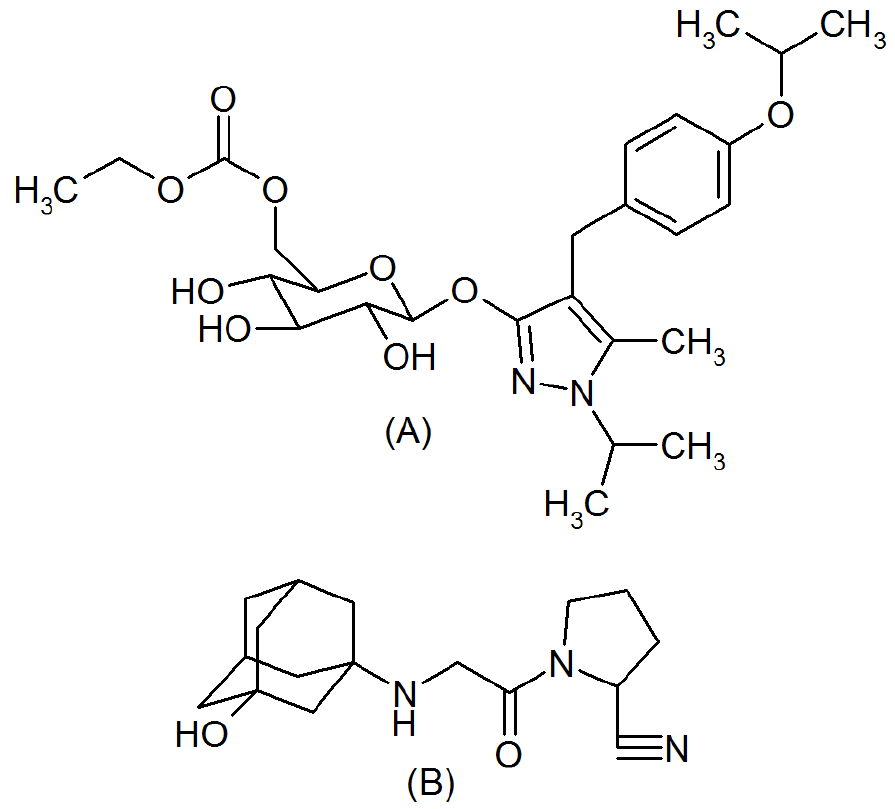
Figure 1. Chemical structure of remogliflozin etabonate ( A ) and vildagliptin ( B ). Few quantitative analytical procedures are illustrated in the literature for the analysis of RGE and VGN alone and with metformin from medicines and biological fluids. A quan- titative determination of RGE alone was explained using UV-Vis spectrophotometry [9,10], HPLC [11,12], and LCMS [13].Derivative UV spectrophotometry, RP-HPLC, and UPLC procedures were stated for the concurrent estimation of RGE with metformin [14–16]. Different analytical methods have been reported in the literature for the quantification of VGN from formulations and biological samples. VGN alone was determined using UV-Vis spectrophotometry [17–19], HPTLC [20], and UPLCMS [21]. Several spectrophoto- metric [22–24] and HPLC [24–27] methods were reported for the determination of VGN along with other